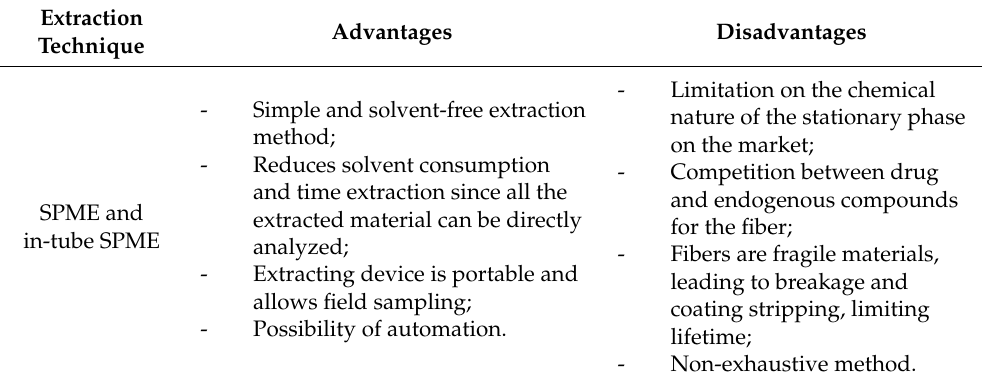
Table 3. Advantages and disadvantages of the SPME and in-tube SPME procedures.